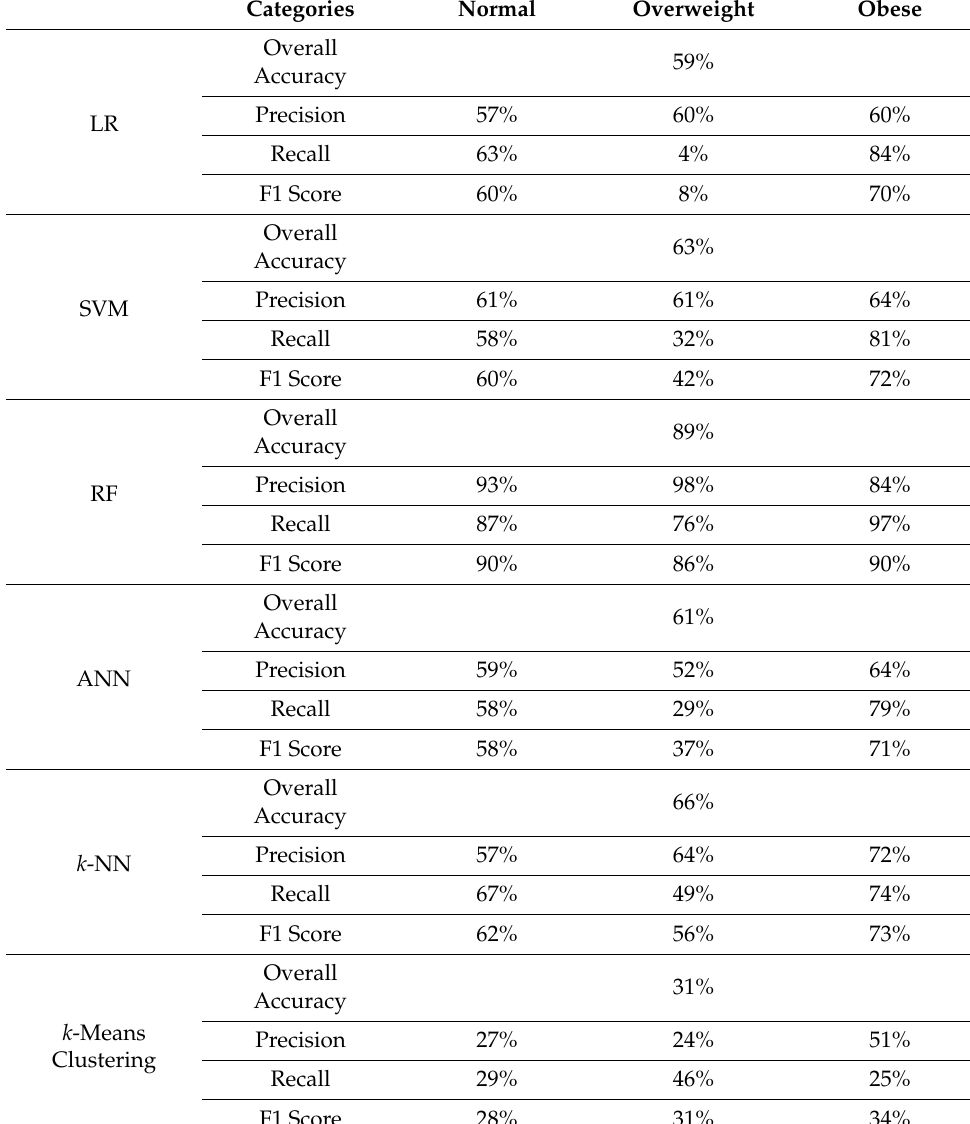
Table 2. Performance of different classification algorithms based on a single well-child visit. Categories Normal Overweight